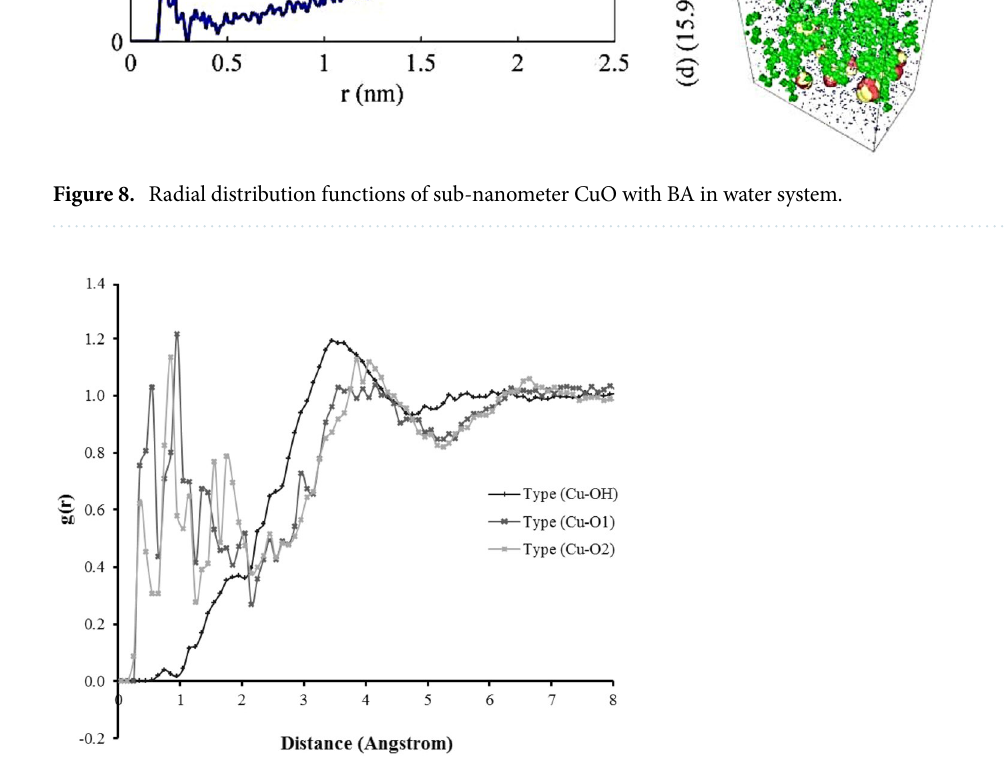
Figure 9. Radial distribution functions of functional group moieties of butyric acid with CuO in a water